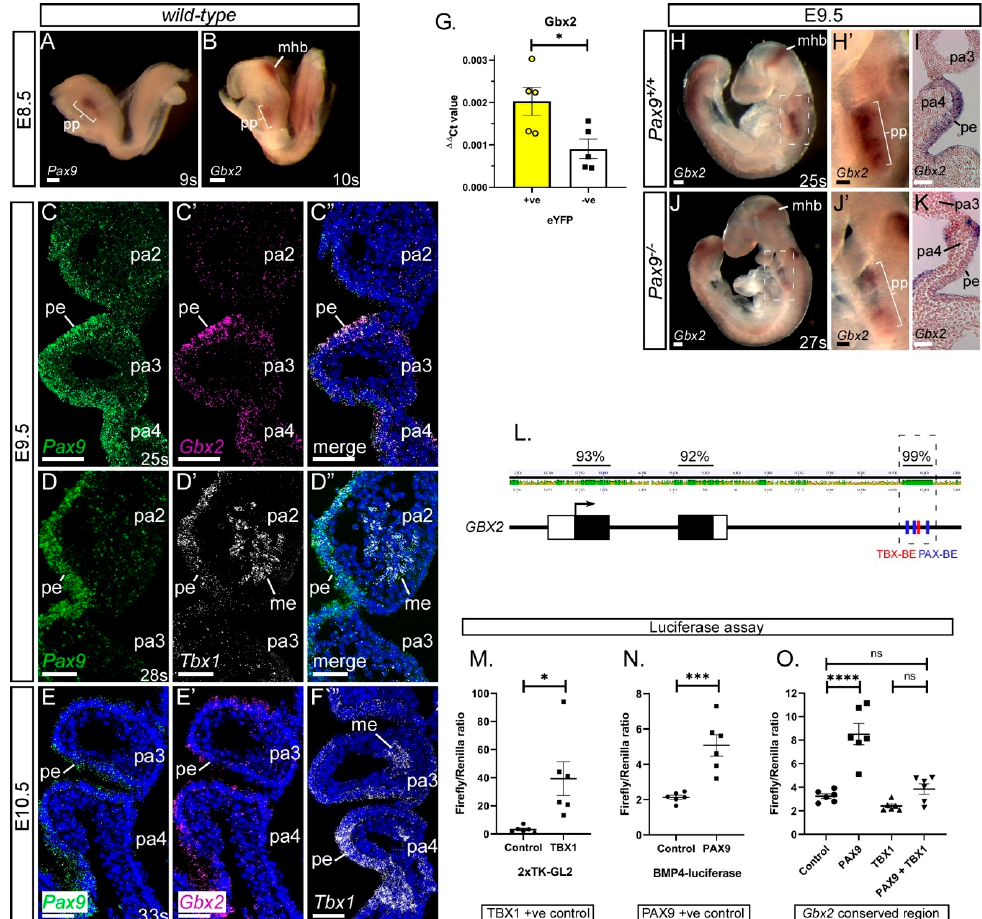
Figure 1. Gbx2 and Pax9 expression in the pharyngeal endoderm. ( A – F ) RNA in situ hybridisation was used to visualise transcripts in the normal developing embryo. At E8.5 whole embryo in